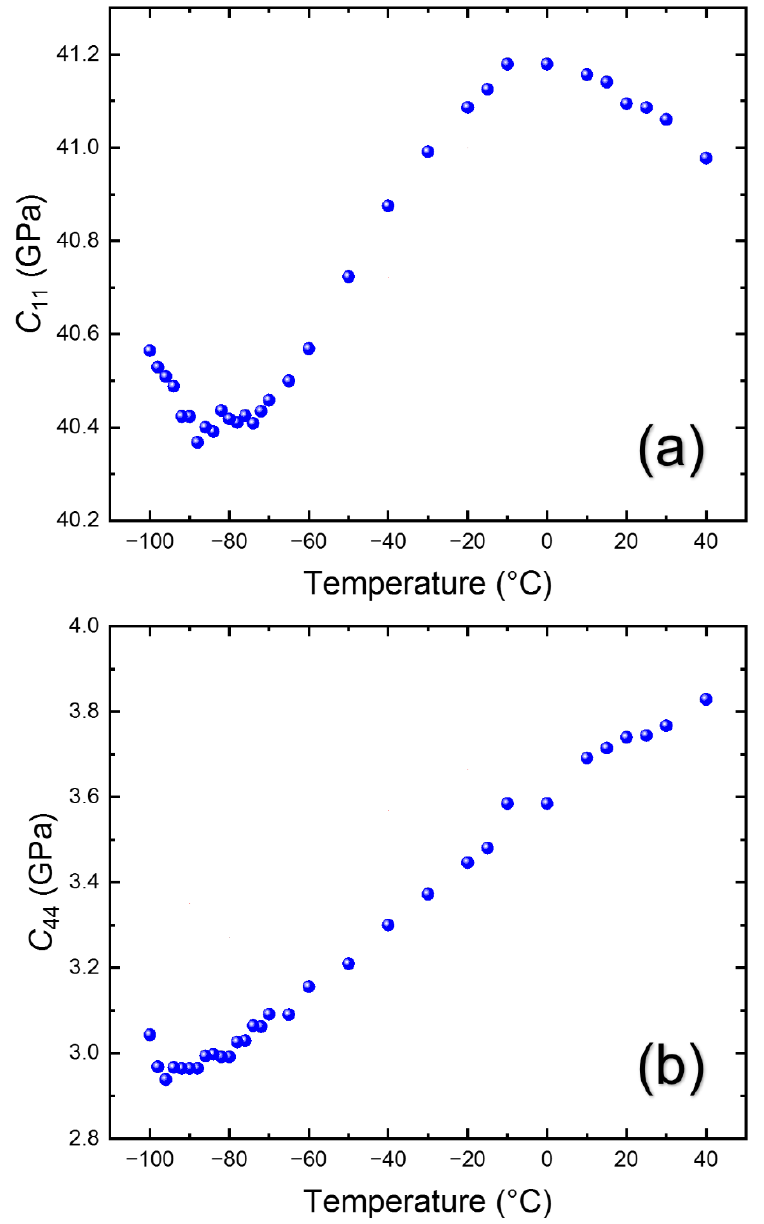
Figure 8. (Color online). Temperature dependences of ( a ) C 11 and ( b ) C 44 in the cubic